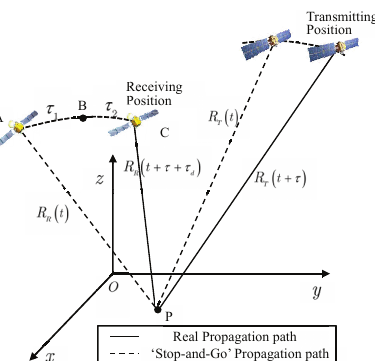
Figure 2. Illustration of propagation path for GEO-LEO